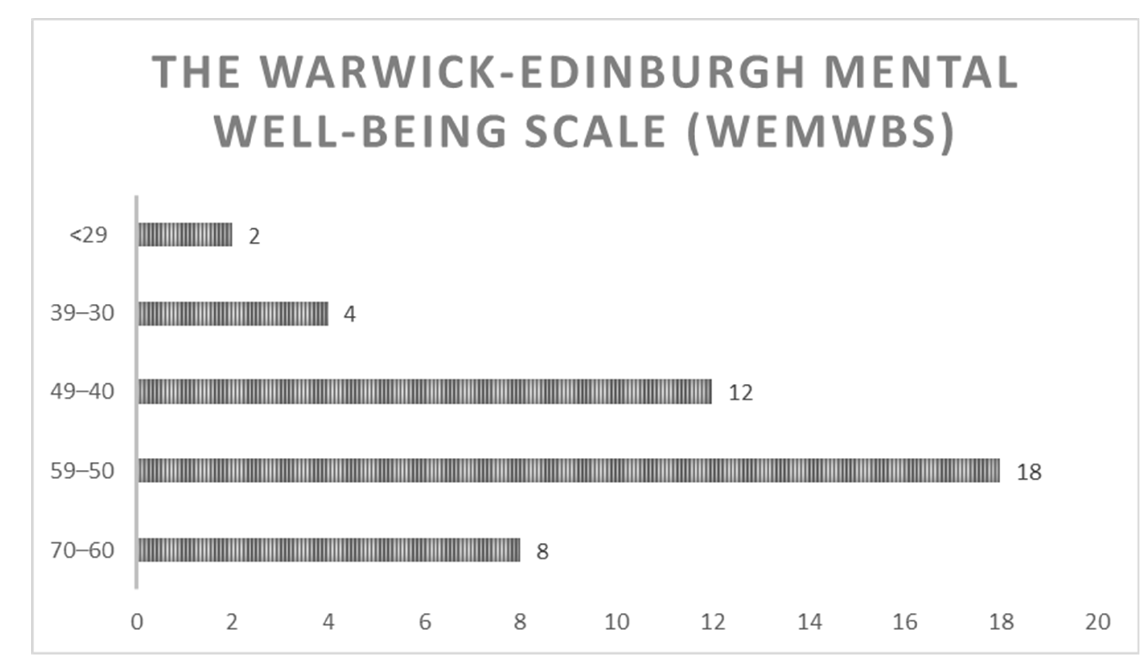
Figure 2. Warwick–Edinburgh Mental Well-Being Scale (WEMWBS) results. The results show the number of patients who have obtained scores between the explained ranges; higher scores represent better results.